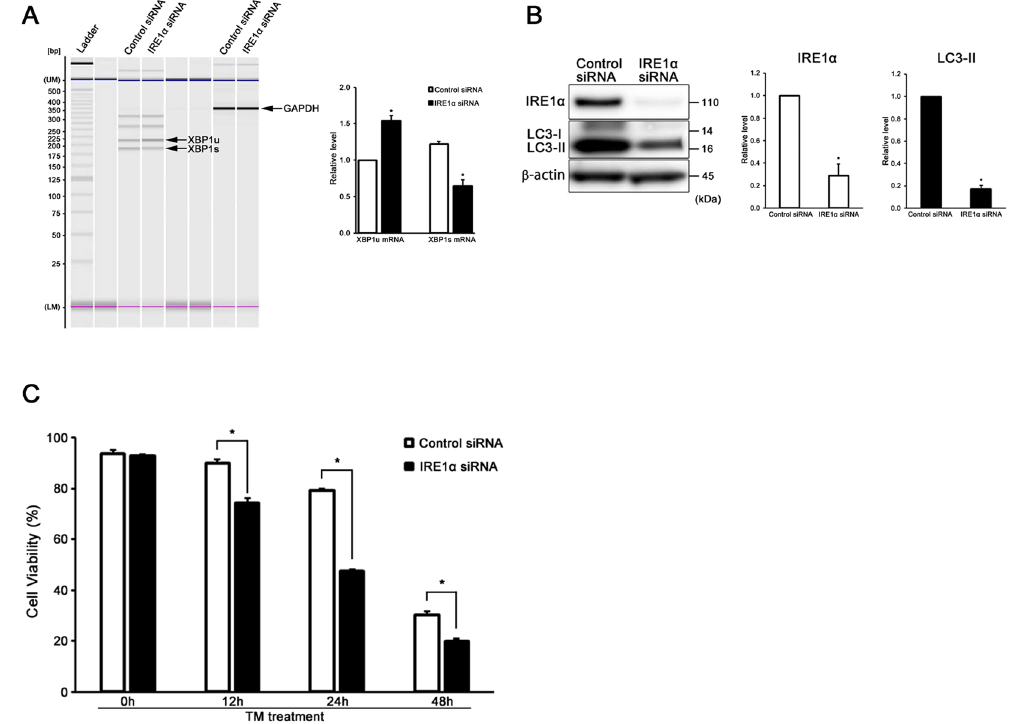
Figure 5. IRE1 α -mediated XBP1 mRNA splicing is necessary for ER stress-induced autophagy in auditory cells. ( A ) RT-PCR analysis showing the expression of XBP1u mRNA and XBP1s mRNA in si-control cells and IRE1 α KD cells. Cells were treated with 50 µ g/ml tunicamycin for 24 h, and the total RNA was extracted and subjected to RT-PCR analysis. GAPDH was included as a loading control. “UM” and “LM” each indicate the upper and lower markers, respectively. The expressions of XBP1u mRNA and XBP1s mRNA were detected, and the mean ± S.D. (fold of changes over the control group) of three independent studies were presented ( * p < 0.05 versus control group). ( B ) Knockdown of IRE1 α suppressed the induction of LC3-II. β -actin was included as a loading control. The expressions of IRE1 α and LC3-II were detected, and the mean ± S.D. (fold of changes over the control group) of three or more independent studies were presented ( * p < 0.05 versus control group). Full- length blots are presented in Supplementary Figure 5a–c. ( C ) After transmission with IRE1 α and control siRNA for 48 h, the cells were treated with tunicamycin (50 µ g/ml for 48 h), and cell viability was measured. The data are shown as mean ± S.D. of three or more independent studies ( * p < 0.05 versus control